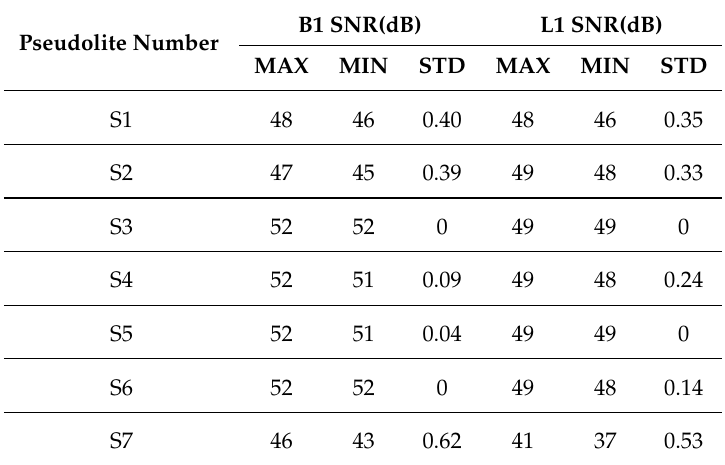
Table 2. The maximum and minimum SNR (signal-to-noise ratio) values and variances.